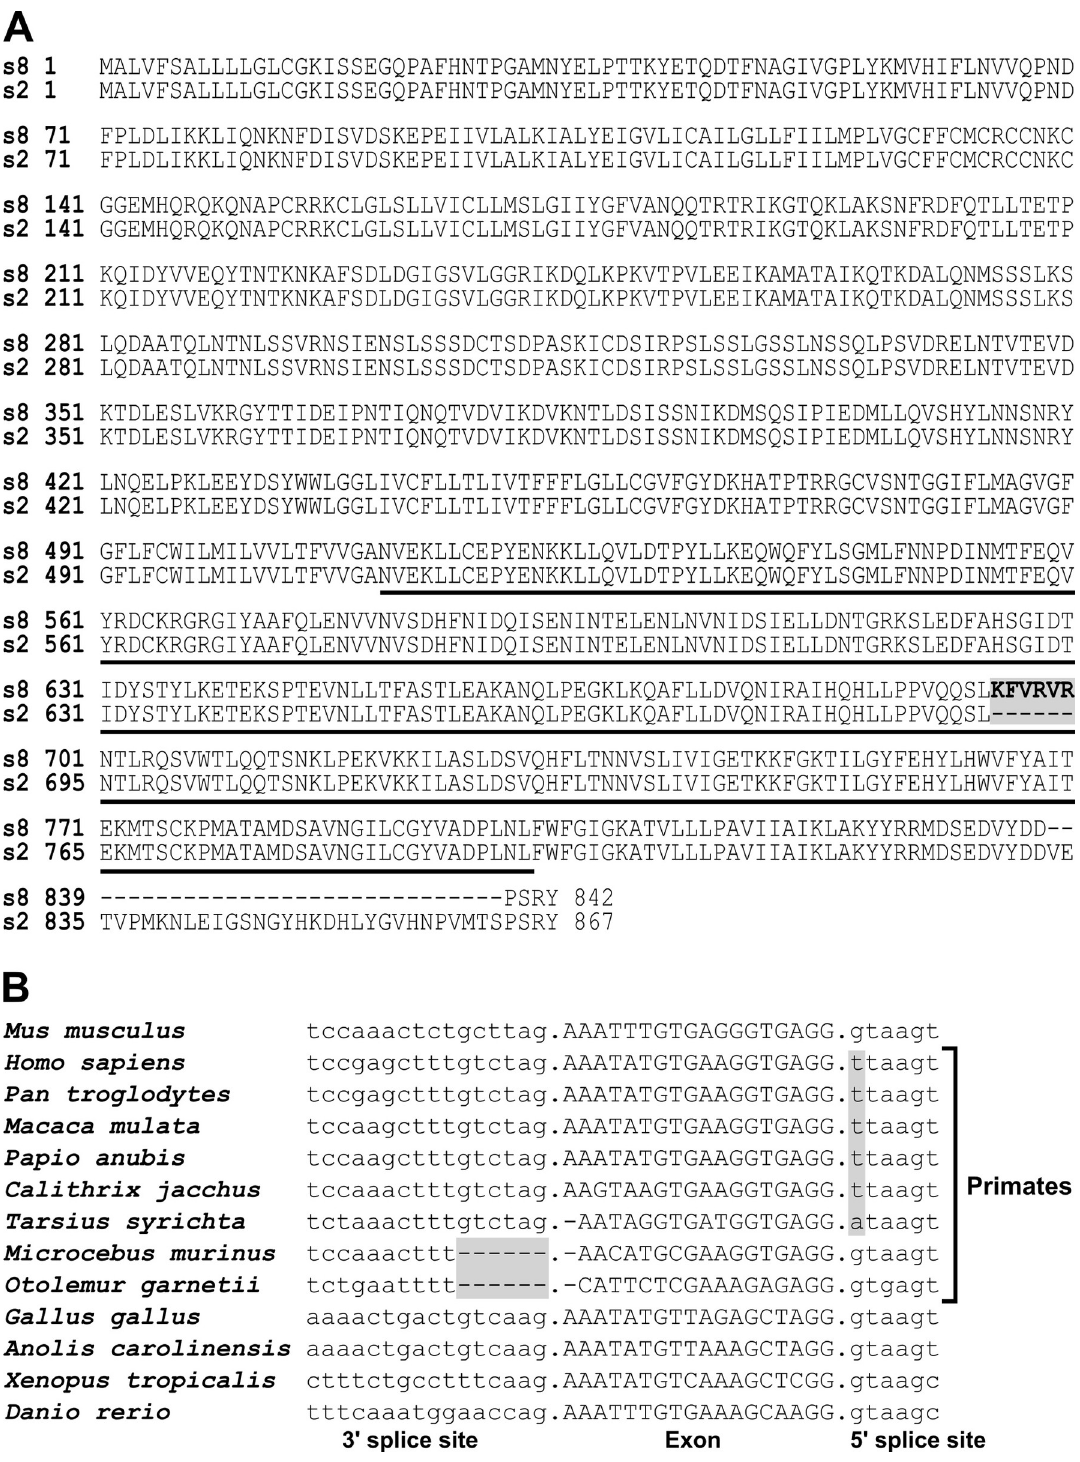
Fig 1. Photoreceptor specific splice variant of PROM1. A) Alignment of the photoreceptor-specific s8 isoform of PROM1 (RefSeq NP_001157057) to the ubiquitously expressed isoform s2 (RefSeq NP_001157049). The amino acids encoded by the photoreceptor specific exon 19 are shown in bold and shaded in gray. The third extracellular domain is underlined. B) Alignment of vertebrate exon 19 sequences including the adjacent 3’ and 5’ splice sites. Mutations inactivating the splice sites in primates are shaded in gray.